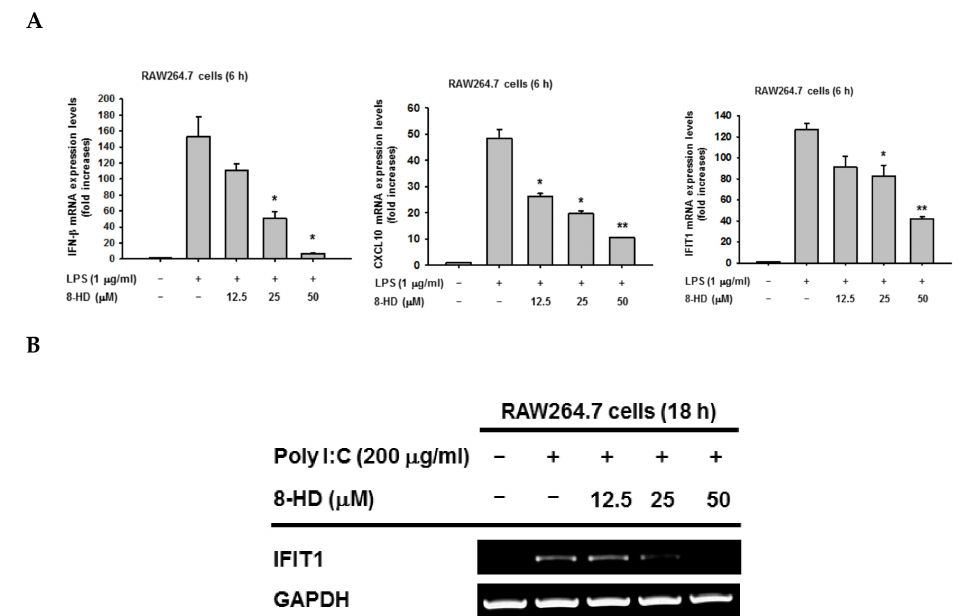
Figure 2. 8-HD downregulates mRNA expression of IRF-3- dependent genes. RAW264.7 cells (10 6 cells / mL) were pre-treated with 8-HD for 30 min, followed by incubation with LPS (1 µ g / mL) for 6 h or Poly I:C (200 µ g / mL) for 18 h. mRNA expression levels of IRF-3-dependent genes ( IFN- β , CXCL10, and IFIT1) were determined by real-time PCR ( A ) or semiquantitative reverse transcriptase PCR (RT-PCR) ( B ). GAPDH was used as a loading control. All data are expressed as mean ± SD. ∗ p < 0.05 and ∗∗ p < 0.01 compared to the control group (LPS